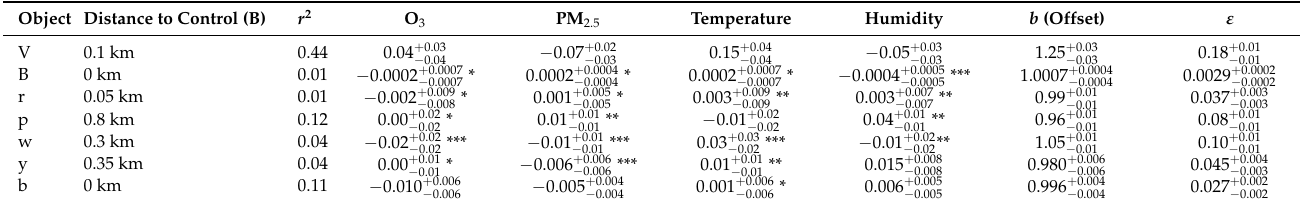
Table A3. MCMC results of the various objects selected in Figure A5, including the r 2 values of the line of best fit and the MCMC median and 3 σ uncertainty of atmospheric coefficient parameters to model the SIFi